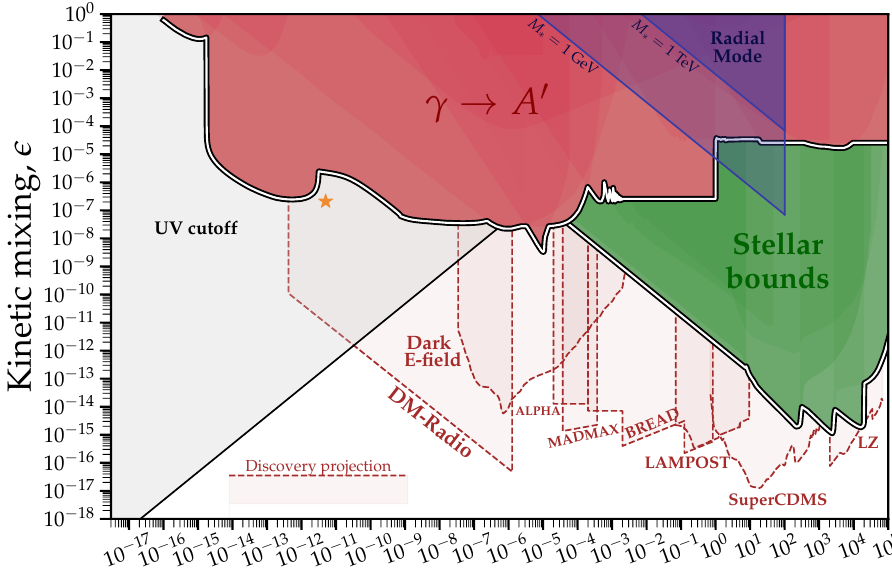
Figure 5 . Parameter space of a Stückelberg dark photon. The red region is excluded by experiments that measure photon-to-dark photon transitions, such as COBE/FIRAS [94] and light-shining- through-walls experiments [95–100]. The green region is excluded by bounds on stellar cooling from the Sun, Horizontal Branch stars and Red Giants [101]. The gray shaded region is ruled out due to the UV cutoff from eq. (3.19). The blue region is ruled out following the existence of the radial mode from eq. (3.16), for which we show two values of M ∗ . The orange star shows the model of [74] which is an attempt to explain the 21 cm EDGES anomaly and is disfavored by our constraints. We note that there are further constraints from the Solar basin around eV masses [102], as well as from superradiance for lower masses